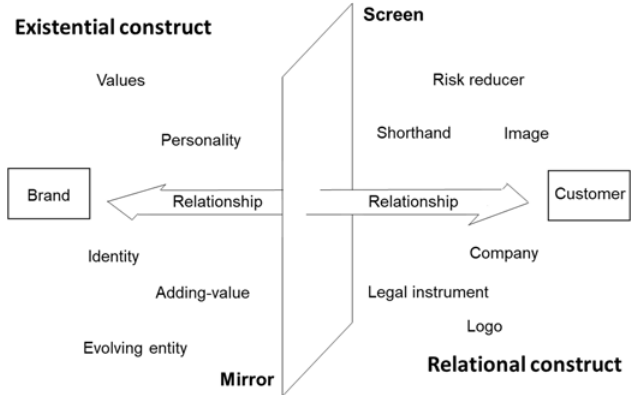
Figure 2. One-way mirror model for brand dimensions according to the personhood of human Figure 2. One ‐ way mirror model for brand dimensions according to the personhood of human be ‐ ings. beings.